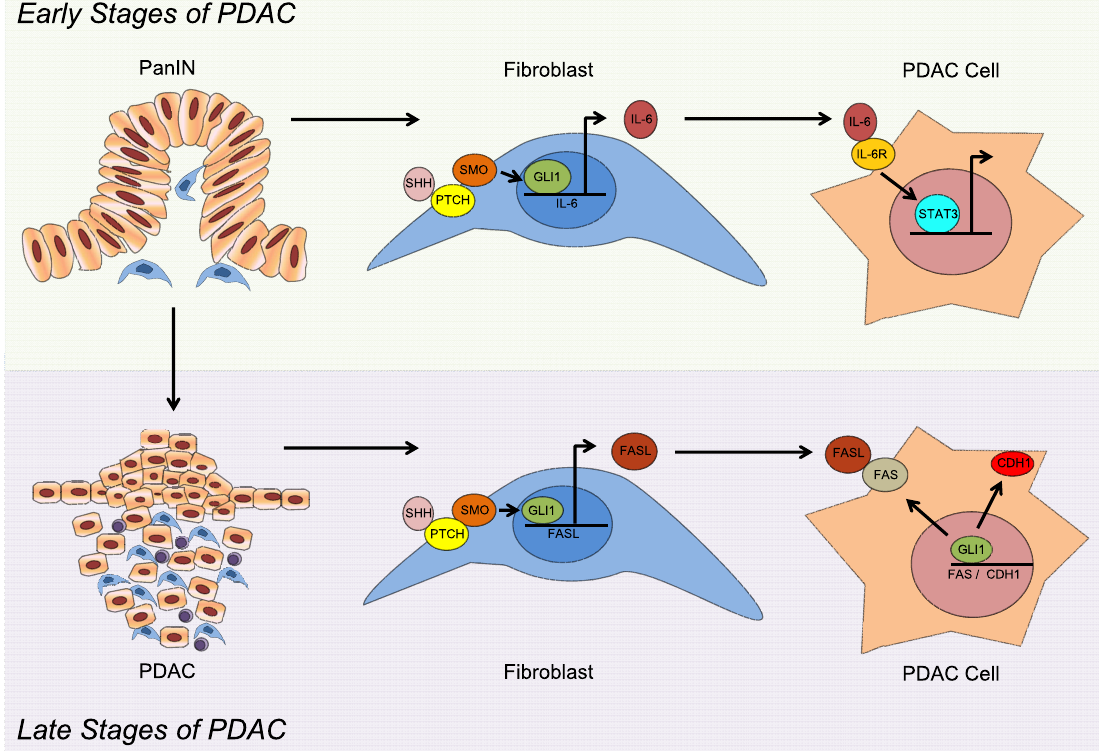
Figure 2. Working Model of the Dual Role of GLI1 at Different Stages of Pancreatic Carcinogenesis. During the early stages of PDAC, GLI1 is activated in the fibroblasts through canonical HH signaling. GLI1 promotes expression of the cytokine IL-6, which stimulates expression of STAT3 in neighboring cancer cells, promoting the progression of PanIN lesions to PDAC. In the later stages of PDAC, GLI1 binds the FASL promoter and regulates the expression of this ligand in the fibroblast, leading to lower levels of apoptosis in these tumors. In addition, in cancer cells, GLI1 induces the expression of FAS and CDH1 expression, leading to a tumor protective